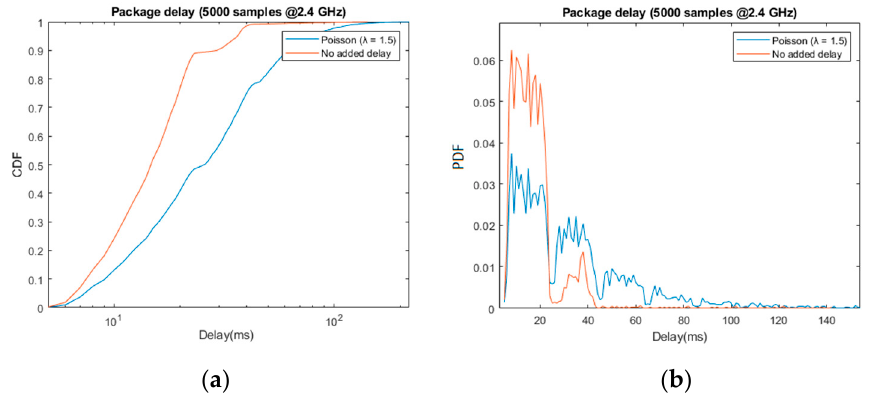
Figure 9. Capture of the update data’s delay before (orange) and after (blue) adding jitter, λ = 1.5. The graphs show the cummulative distribution function ( a ) and probability distribution function ( b ) of the sample (5000 packages sent). Table 1. Delay statistics of the update packages.